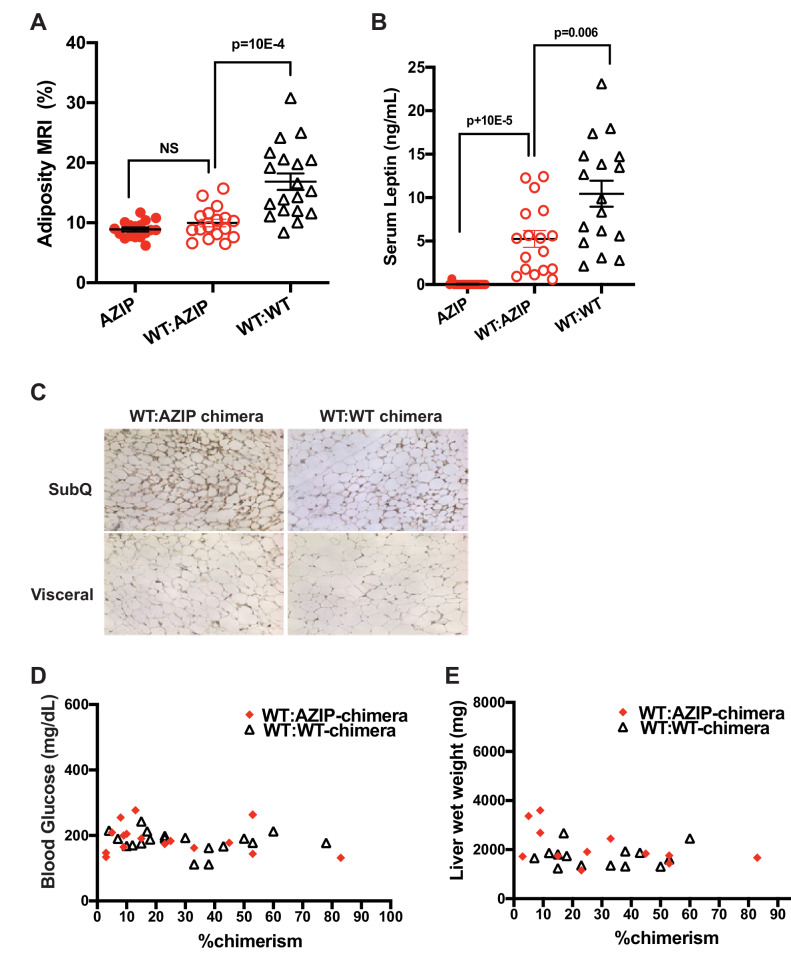
B6 Chimeras on Chow Diet.(A) Body fat content measured by MRI at 12 weeks. There were no significant difference between AZIP and WT:AZIPs and WT:AZIP-chimeric mice are generally leaner than WT:WT-chimeric mice. (B) Serum leptin levels of three groups of animals. Complementation by ES-cells rescued hypoleptinemia phenotype, where non-chimeric AZIP mice have non-detectable levels of leptin and AZIP-chimeras show serum leptin levels ranging from 0.6 to 12.5 ng/mL. (C) Microscopy study of epididymal white adipose tissue (visceral) and inguinal subcutaneous white adipose tissue (SubQ) of WT:AZIP- and WT:WT-chimeras. AZIP-chimera shown here is 10% chimeric and WT-chimera was 8% chimeric. Brown color represents staining for YFP. Note comparable cell size in both tissues. (D) Chimerism versus blood glucose in WT:AZIP- and WT:WT-chimeras. No difference was detected between high and low percent chimerism. (E) Liver wet weight in mg in WT:AZIP and WT:WT chimeras show no relationship to degree of chimerism. For (A), (B) and (D), n = 17 for AZIP, n = 17 for WT:AZIP-chimeras, and n = 19 for WT:WT-chimeras. For (E), n = 12 for WT:AZIP-chimera, and n = 14 for WT:WT-chimeras, and liver analysis are performed at 6 months old.